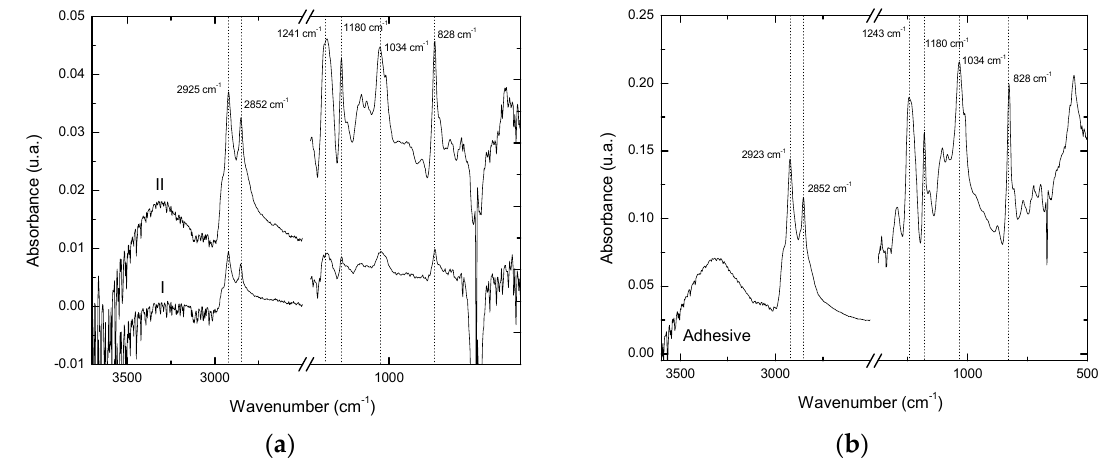
Figure 18. FTIR spectra: ( a ) From both faces I and II of the adhesive bond after the shear strength test; ( b ) From the cured hybrid